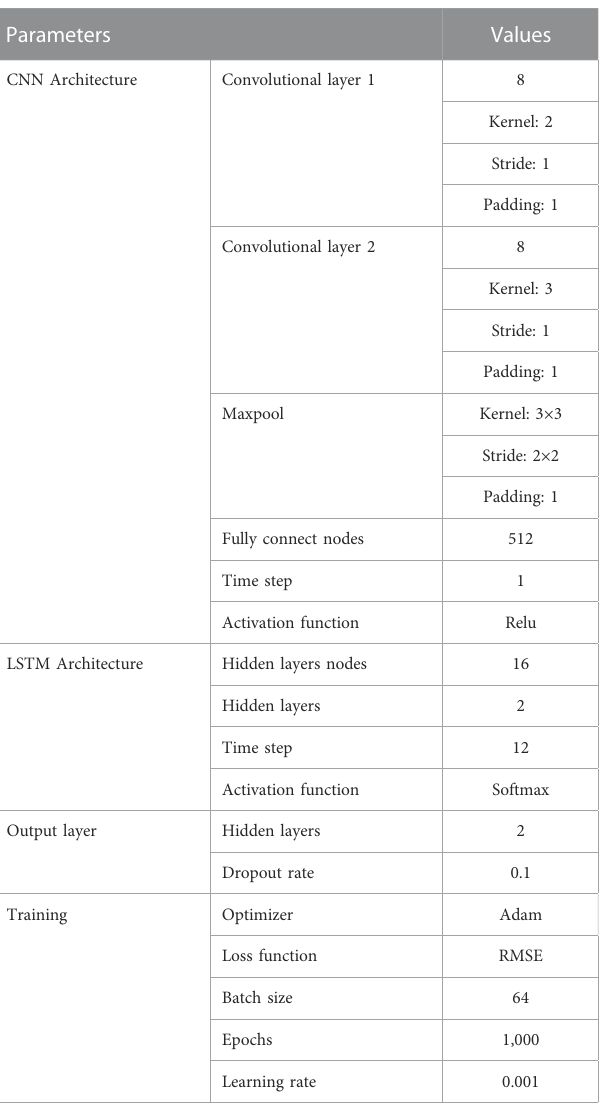
TABLE 2 Setting of hyperparameters.